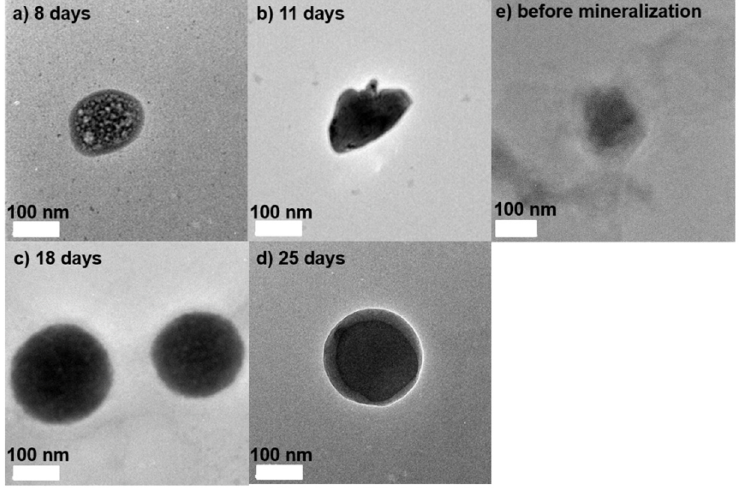
Figure 3. TEM images of vesicles after CaCO 3 mineralization for ( a ) 8 days, ( b ) 11 days, ( c ) 18 days, and ( d ) 25 days. ( e ) TEM image of the vesicle before mineralization. and ( d ) 25 days. ( e ) TEM image of the vesicle before mineralization.